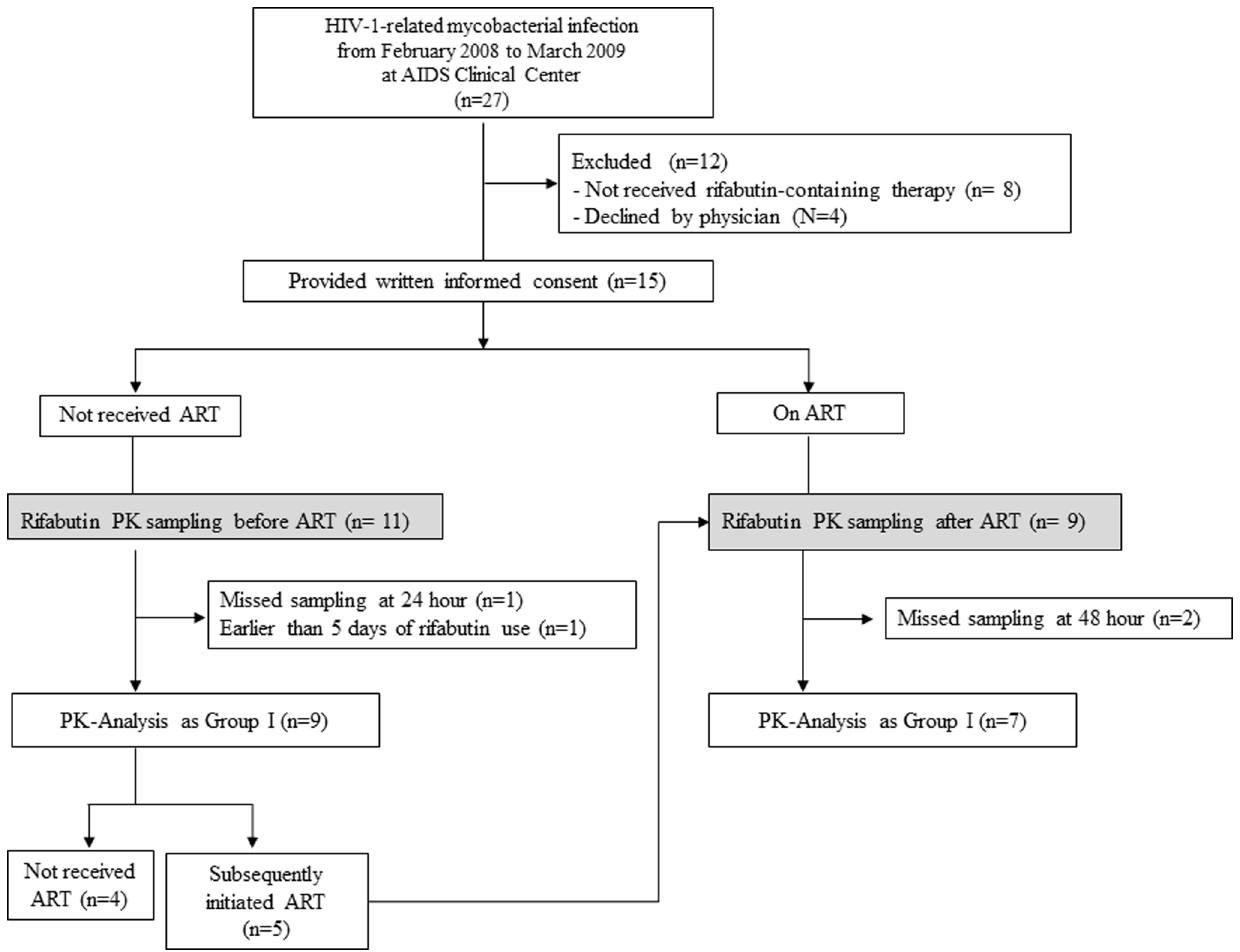
Figure 1. Flow chart of participants through the study. PK, pharmacokinetic; ART, antiretroviral therapy.